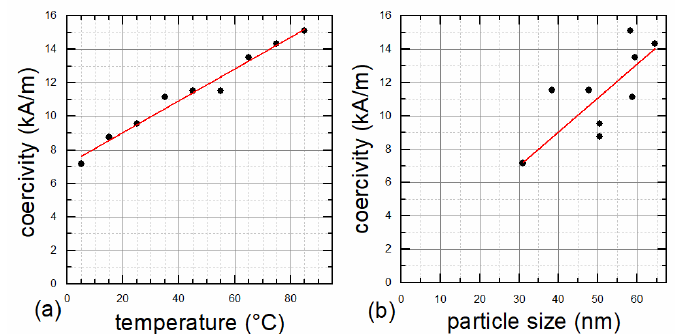
Figure 5. Coercivity at 300 K as function of synthesis temperature ( a ) and XRD particle diameter ( b ). Lines serve as a guide to the eye only.